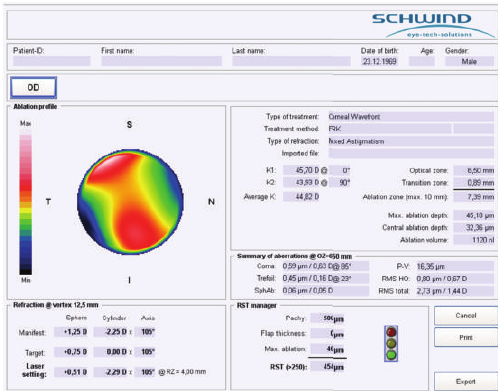
Figure 2: RE preoperative pachymetry map generated by Orbscan II, with thinnest corneal point of 472 𝜇 m. Figure 3: RE ablation map (topographic guided ablation) showing